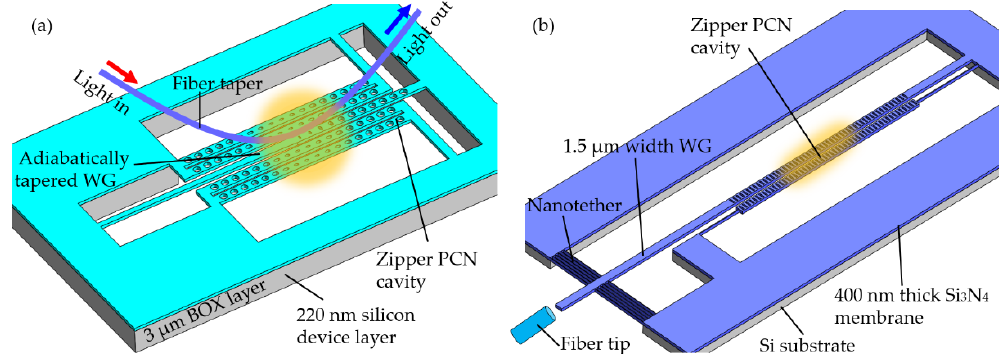
Figure 15. Schematics of squeezed light in optomechanics for displacement sensing: ( a ) waveguide- coupled zipper optomechanical PCN cavity [112] ; ( b ) optical fiber tip routed zipper PCN cavity [61] .